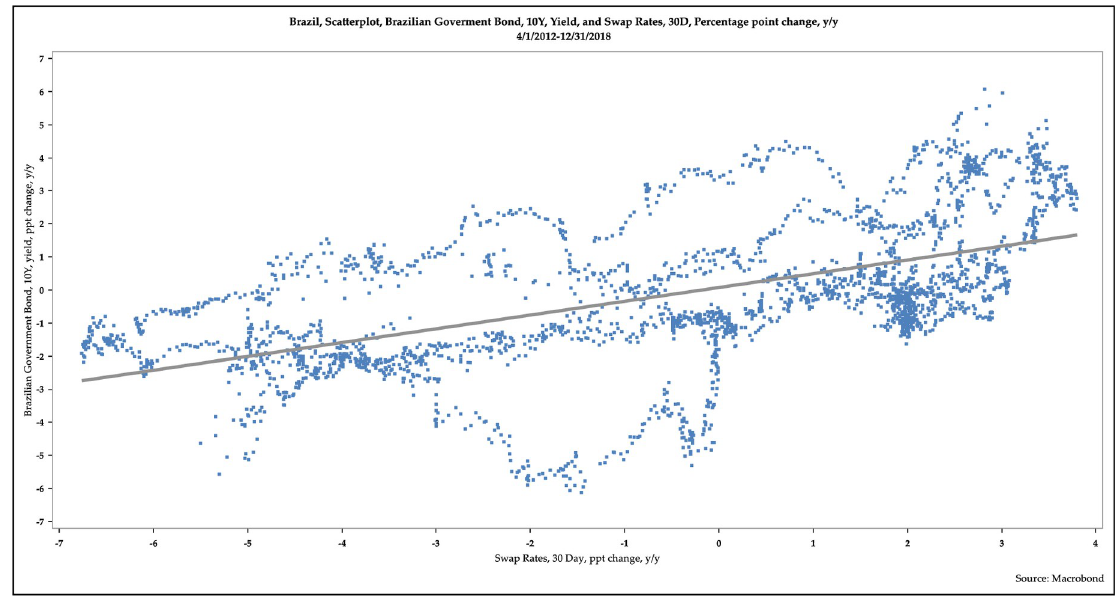
Fig 8. Scatterplot of the year-over-year percentage point changes in the yields of 10-year Brazilian government bonds and 30-day swaps.